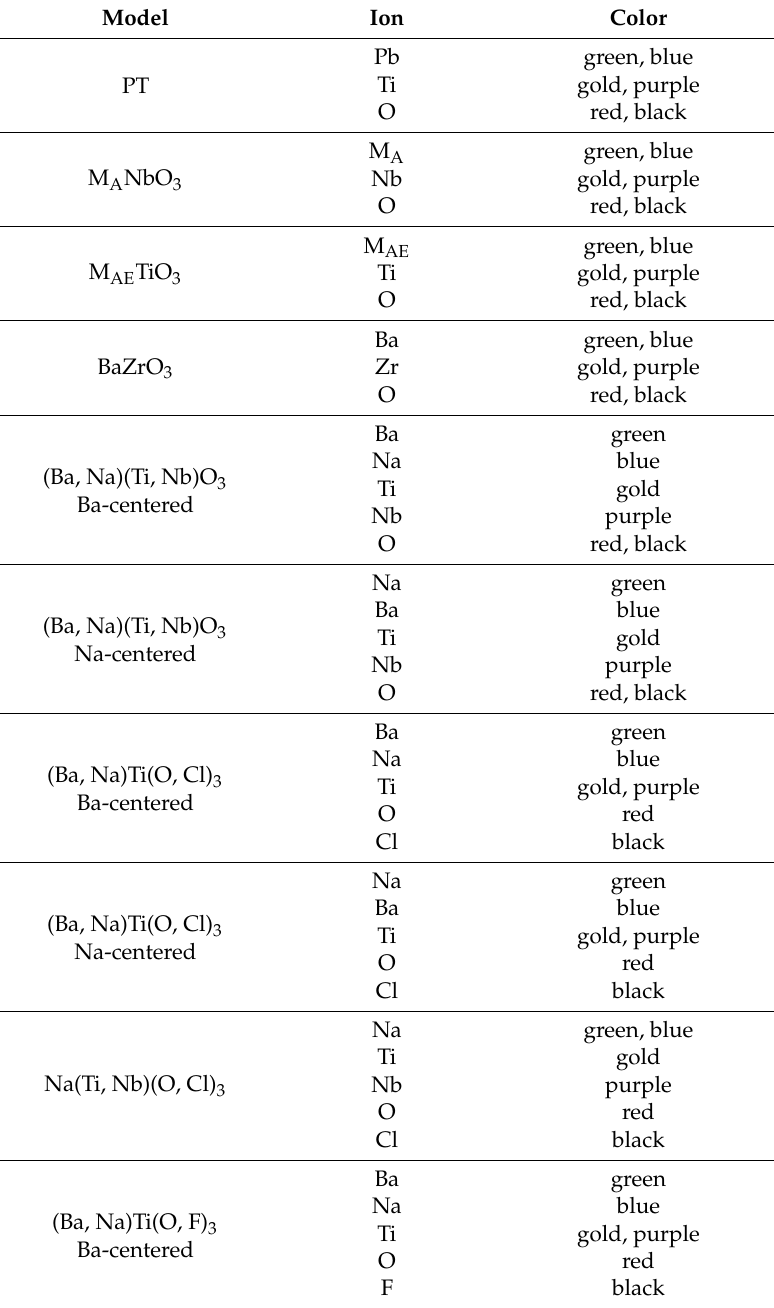
Table 1. Colors of the ions in each perovskite